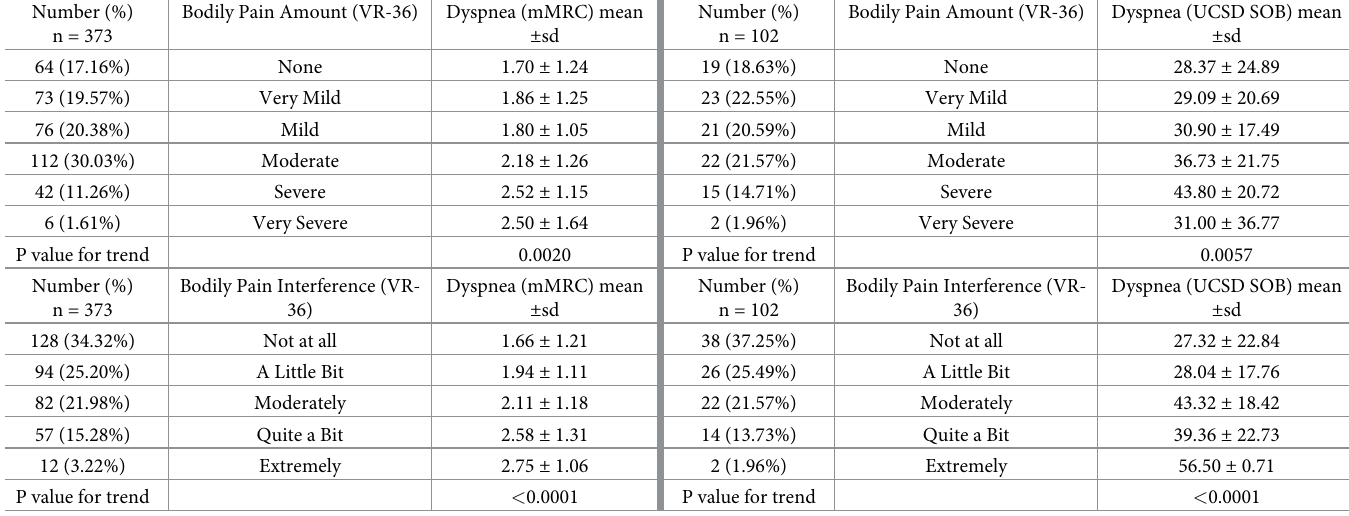
Table 2. Increasing bodily pain (2a) and pain interference (2b) are associated with increasing dyspnea. Number (%) n =